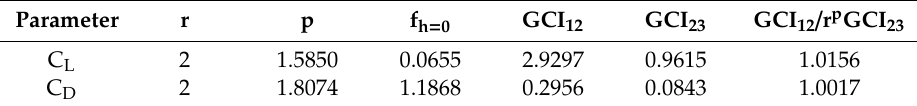
Table 6. Results of grid convergence